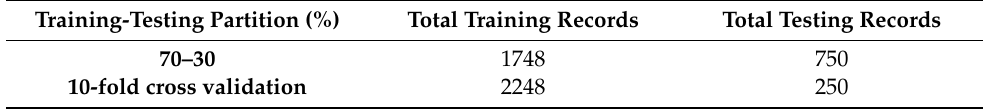
Table 2. Class distribution of beach visitors.